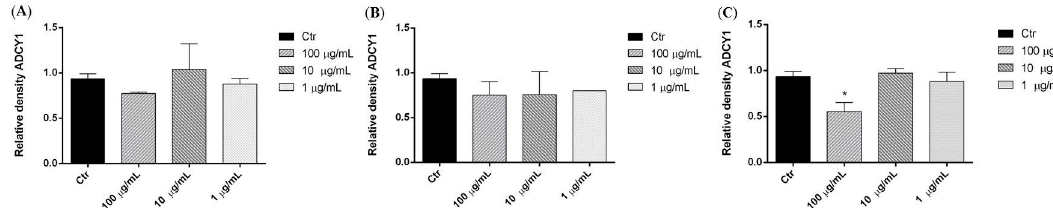
Figure 4. Relative expression levels of the ADCY1 protein in SH-SY5Y cells treated with petroleum ether ( A ), chloroform ( B ), methanol ( C ) extracts. Each panel shows the densitometric analysis of bands in the treated groups and control. Values are the mean ± SD in each group ( n = 3). * p < 0.05, compared to control (ANOVA followed by Dunnett’s multiple comparison test).